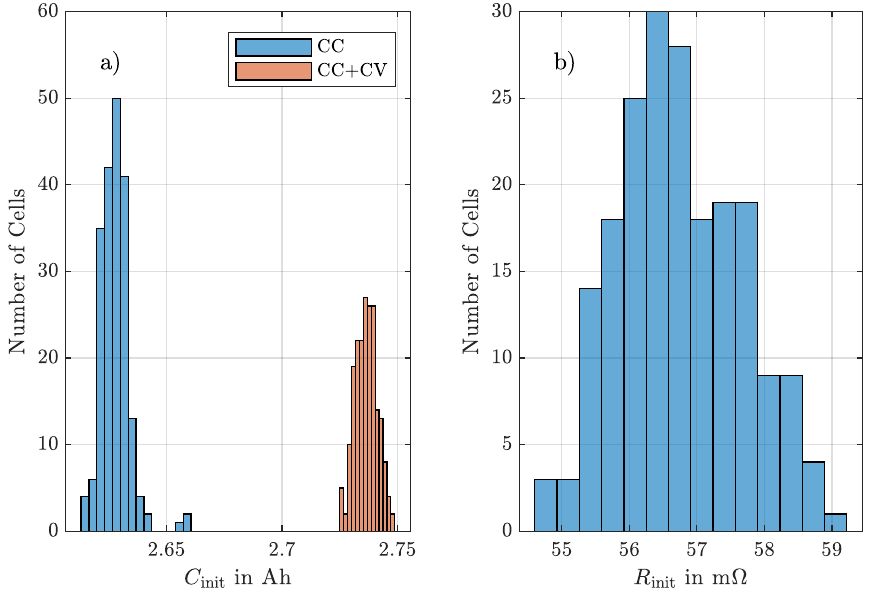
Figure 1. ( a ) Histograms of cell capacity and ( b ) histogram of internal resistances of 200 cells measured in an initial characterization